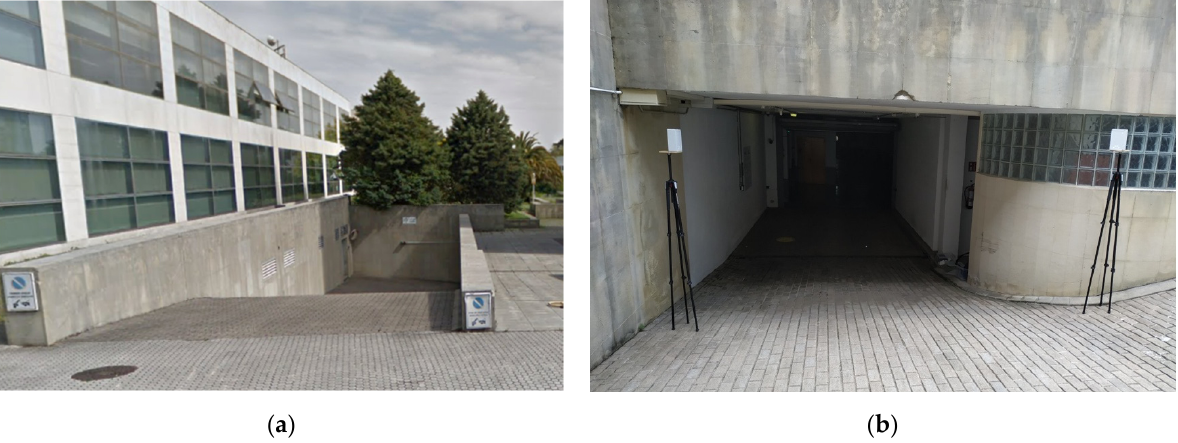
Figure 5. Example pictures of the harsh environment: ( a ) beginning of the urban canyon and ( b ) beginning of the indoor environment.